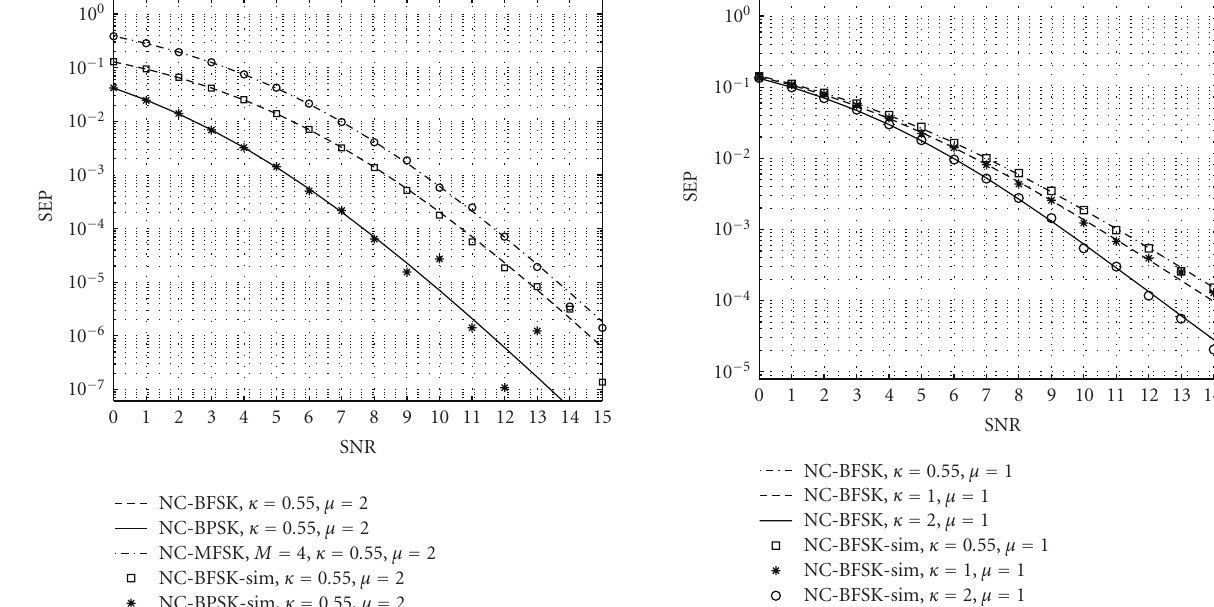
Figure 15: BEP/SEP for noncoherent detection, 3-branch diversity. Symbol error probability without diversity and for